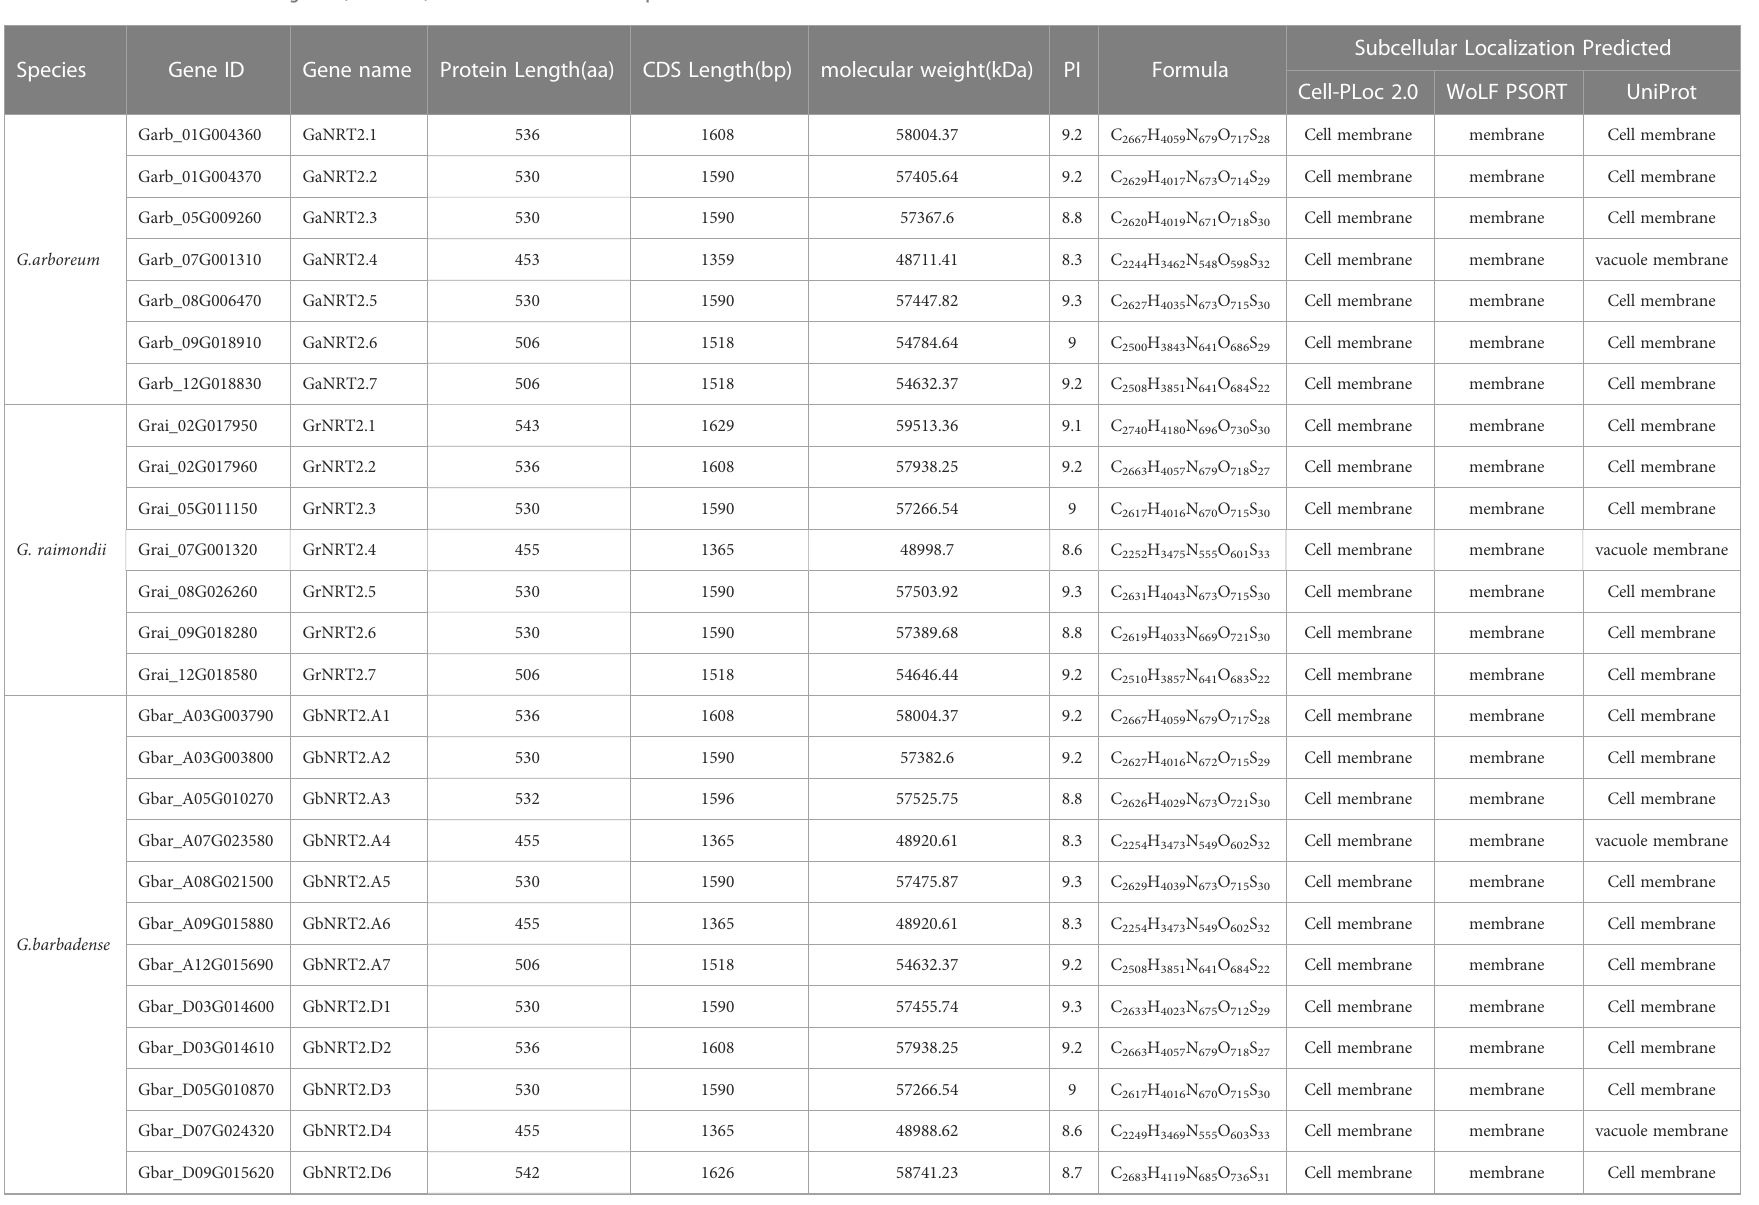
TABLE 1 Features of the 42 NRT2 genes (GhNRT2s) identi fi ed in four cotton